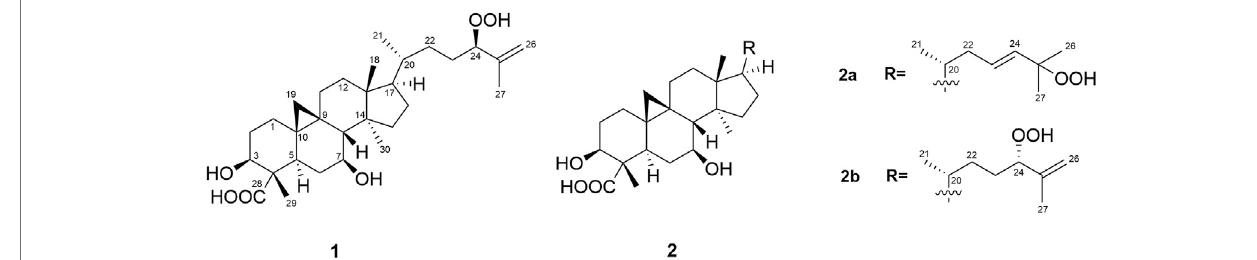
FIGURE 1 | Structures of the isolated compounds ( 1 and 2a , 2b